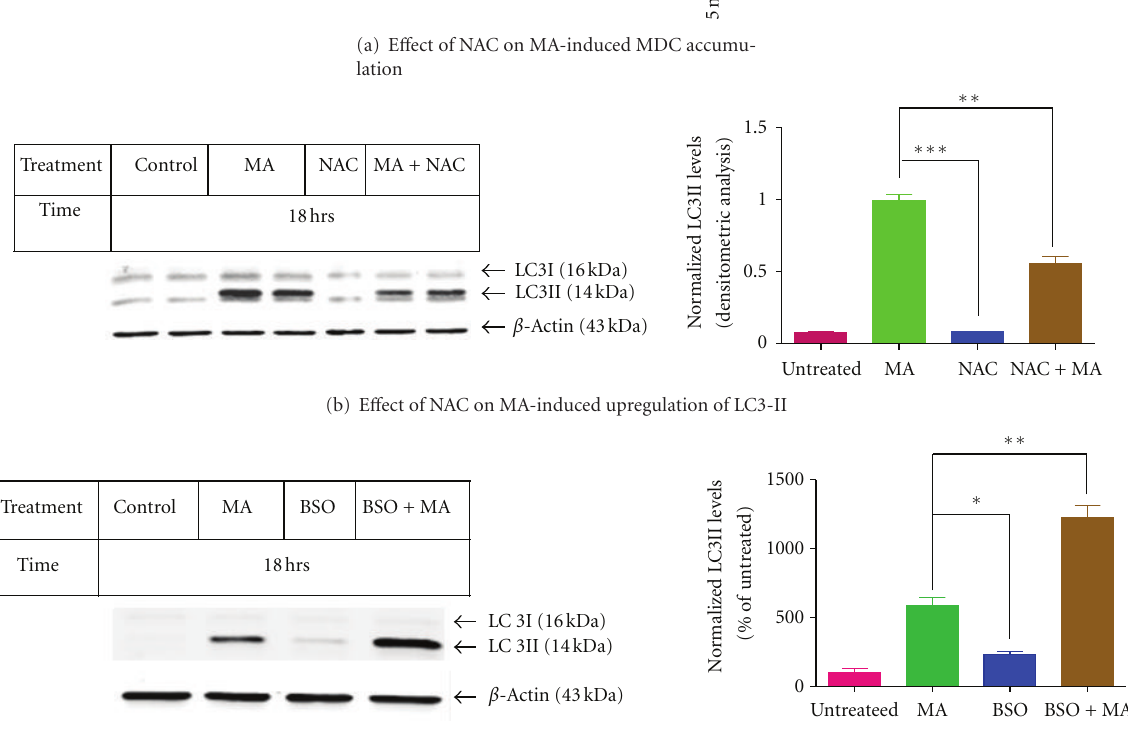
Figure 3: (a) E ff ect of NAC on MA-induced accumulation of monodansylcadaverine (MDC) in autophagy vacuoles. N27 dopaminergic cells were preincubated with 5mM NAC for an hour prior to exposure to MA (2mM) for 18 hours. MA-induced changes in intracellular MDC fluorescence were measured as indicated in Methods. The data represent mean ± SEM of four individual measurements. Asterisks ( ∗ P < 0 . 05 and ∗∗ P < 0 . 01) indicate significant di ff erences between MA-treated cells and NAC alone or NAC with MA-treated cells. Values are expressed as percentage of MDC specific activity compared to untreated control cells. Treatment of N27 dopaminergic cells with 20 μ M chloroquine is considered as test control. (b) NAC reduced LC3-II levels in N27 dopaminergic cells treated with MA. Western blot analysis of LC3-II expression in N27 dopaminergic cells after exposure to MA (2mM) with or without 5mM NAC during 18 hour treatment is presented. Equal loading of protein in each lane is confirmed by probing the membrane with β -actin antibody. Densitometry analysis of LC3-II induction ( n = 2) is represented next to the Western blot image. (c) BSO enhances the expression of LC3-II. N27 dopaminergic cells were pretreated with 100 μ M BSO for 24 hours and treated with MA for another 18 hours. Equal loading of protein in each lane is confirmed by probing the membrane with β -actin antibody. Densitometry analysis of LC3-II induction is represented next to the Western blot image. LC3-II bands were quantified and expressed as percentage of untreated control. Data represent ± SEM, n = 2. ∗ P < 0 . 05, ∗∗ P < 0 . 01, and ∗∗∗ P < 0 . 001 compared with MA-treated